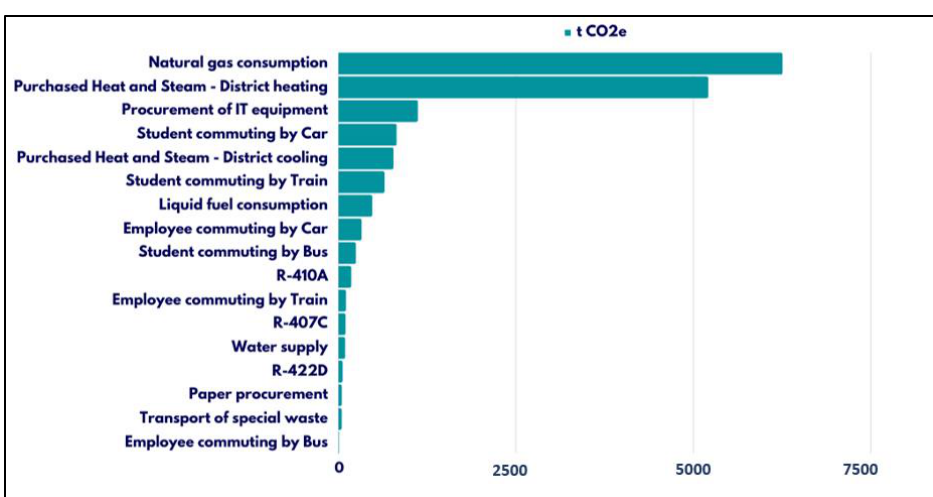
Figure 4. Tons of CO 2e by activity subset.